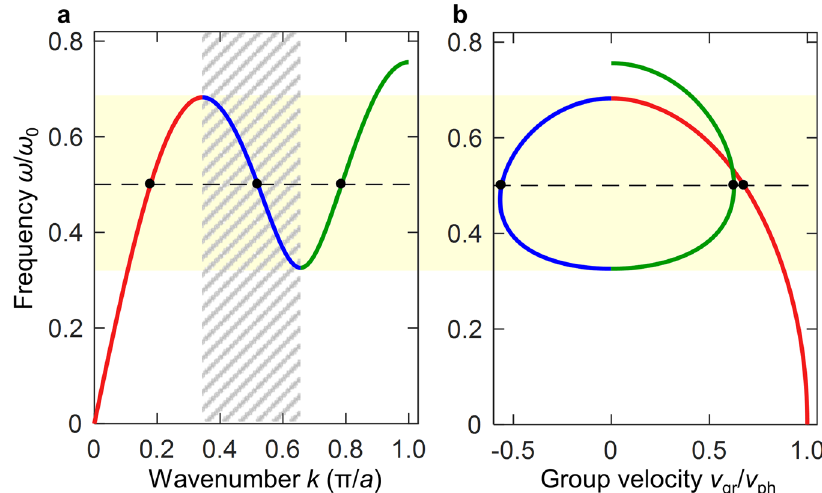
Fig. 1 Roton-like acoustical wave dispersion relation. a The acoustical wave ’ s angular frequency ω k ð Þ is depicted versus wavenumber k . The dispersion relation starts off with the usual linear increase of ω versus k . At a fi nite characteristic wavenumber, the dispersion relation exhibits a parabolic minimum. In a certain frequency range (highlighted by the light-yellow background), a single frequency ω leads to three modes at different k (exempli fi ed by the dashed line and the black dots), hence different wavelengths λ ¼ 2 π = k . In the hatched wavenumber interval, the group velocity v whereas the phase velocity v ph ¼ ω = k is positive. In a crystal with period a , the edges of the fi rst Brillouin zone at wavenumbers ± π = a are important. b Corresponding group velocity versus angular frequency ω , normalized by the phase velocity in the long-wavelength limit, k ! 0. The different colors serve to connect the different parts of the dispersion relation between a and b . Panels a and b can be taken as schemes. They actually correspond to solutions of the 1D toy model (cf. Fig. 2b) with parameters N ¼ 3, K N = K